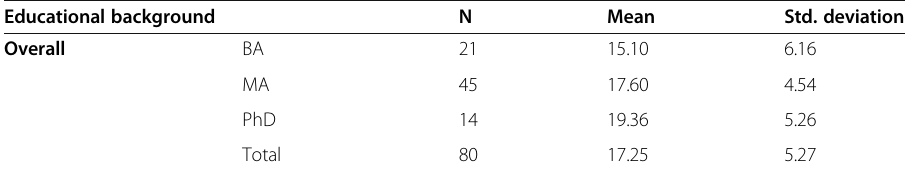
Table 5 Total questionnaire mean according to educational background Educational